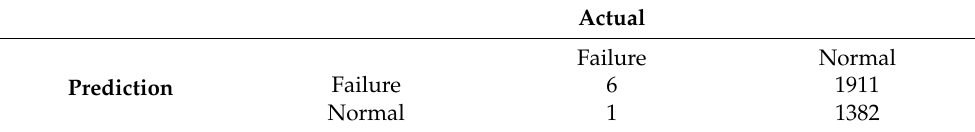
Table 15. Prediction results obtained for the RNF diagnosis using the confusion matrix.